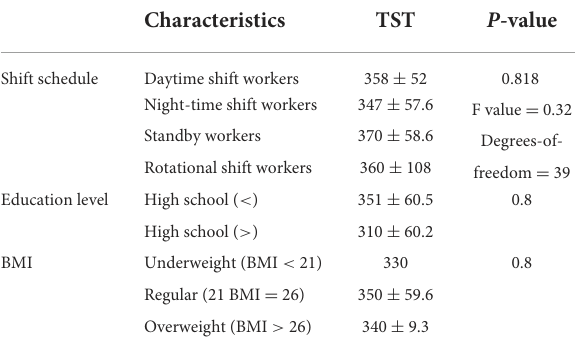
TABLE 3 Shift laborers of different groups and total sleep time (TST)